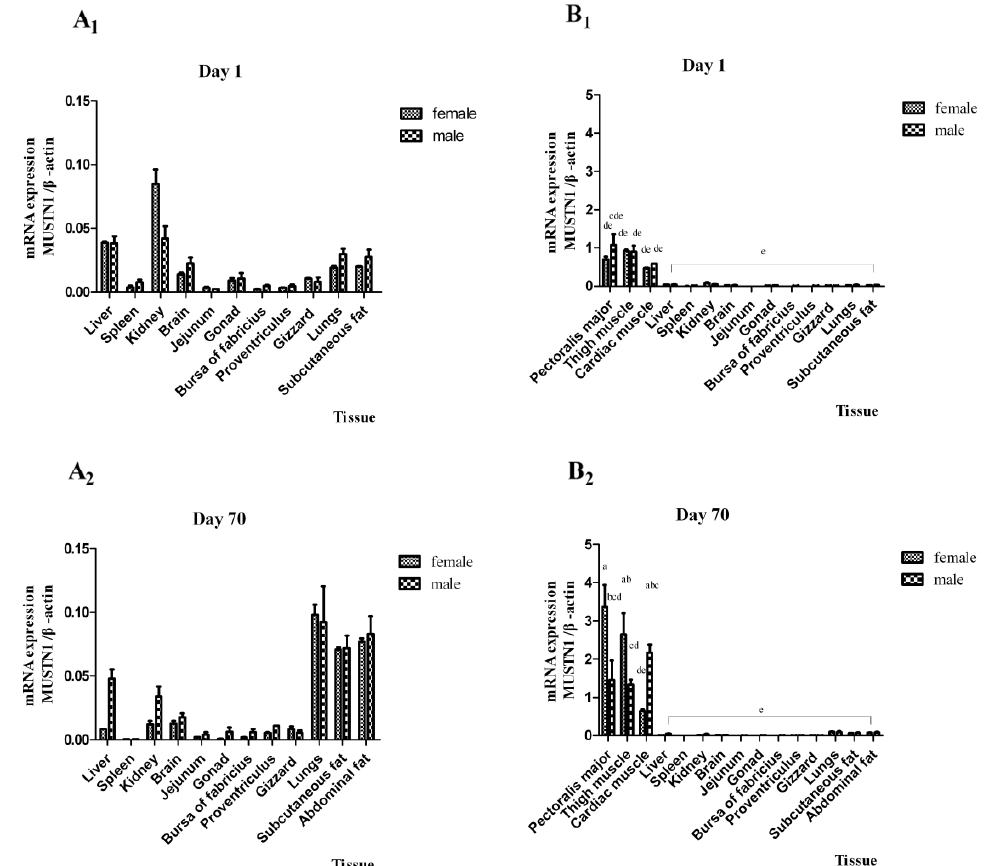
Figure 1. Relative amount of MUSTN1 mRNA among tissues in male and female chickens at day 1 ( A , B ) and day 70 ( A , B ) post-hatch. To better illustrate the relative 1 1 2 2